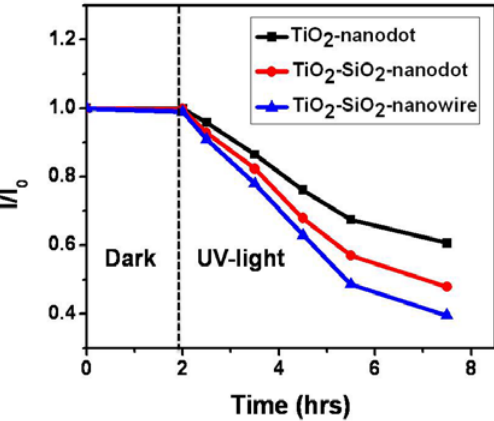
Figure 6. Photocatalytic degradation of methylene blue: plot of the ratio of intensity of peak at 664 nm (I/I ) with 0